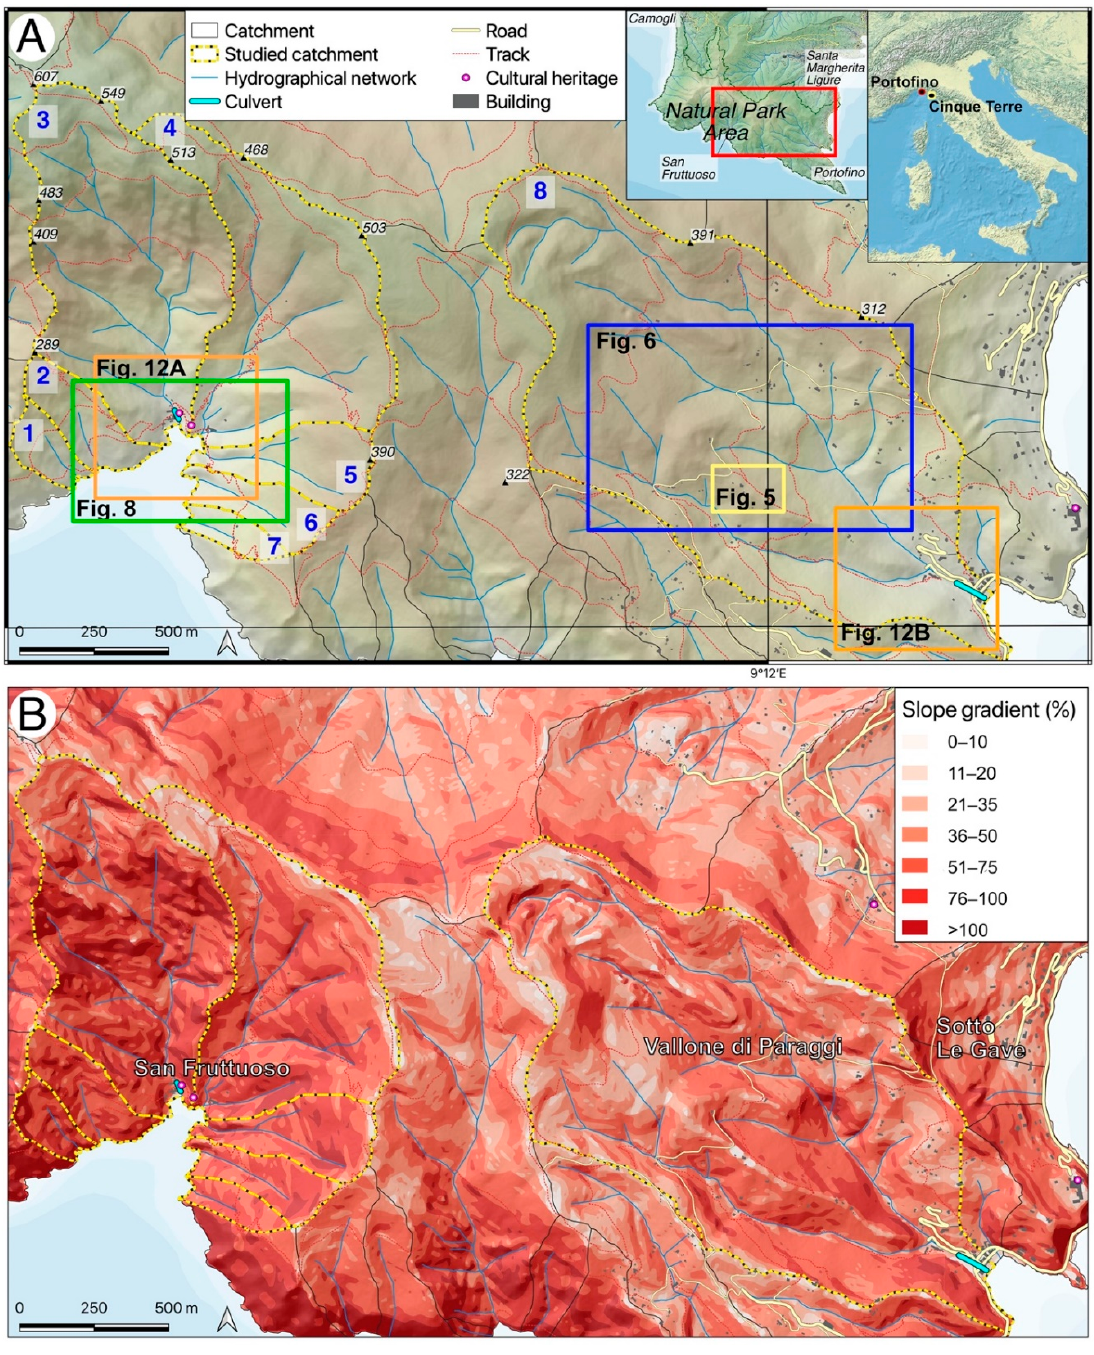
Figure 1. ( A ): A geographical sketch of the studied area; the numbers show the small catchments and colored boxes are references for figures 5, 6, 8, 9. ( B ): The slope gradient in the area. The geology of Portofino Mount is made of two rock masses [33,34] (Figure 2): (1) Portofino Conglomerate, in the south-facing small catchments between the two